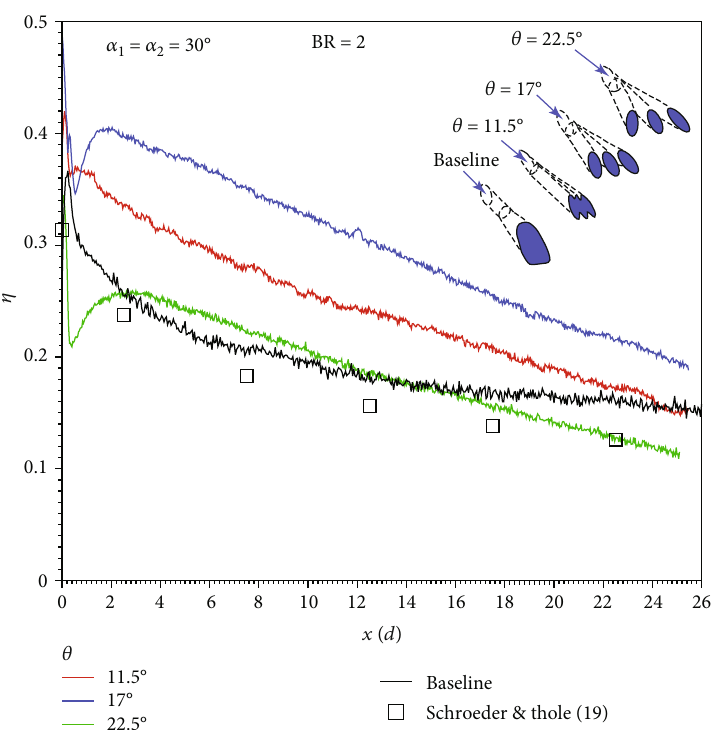
Figure 20: Streamwise (laterally averaged) fi lm e ff ectiveness variations for α BR = 2 : 0